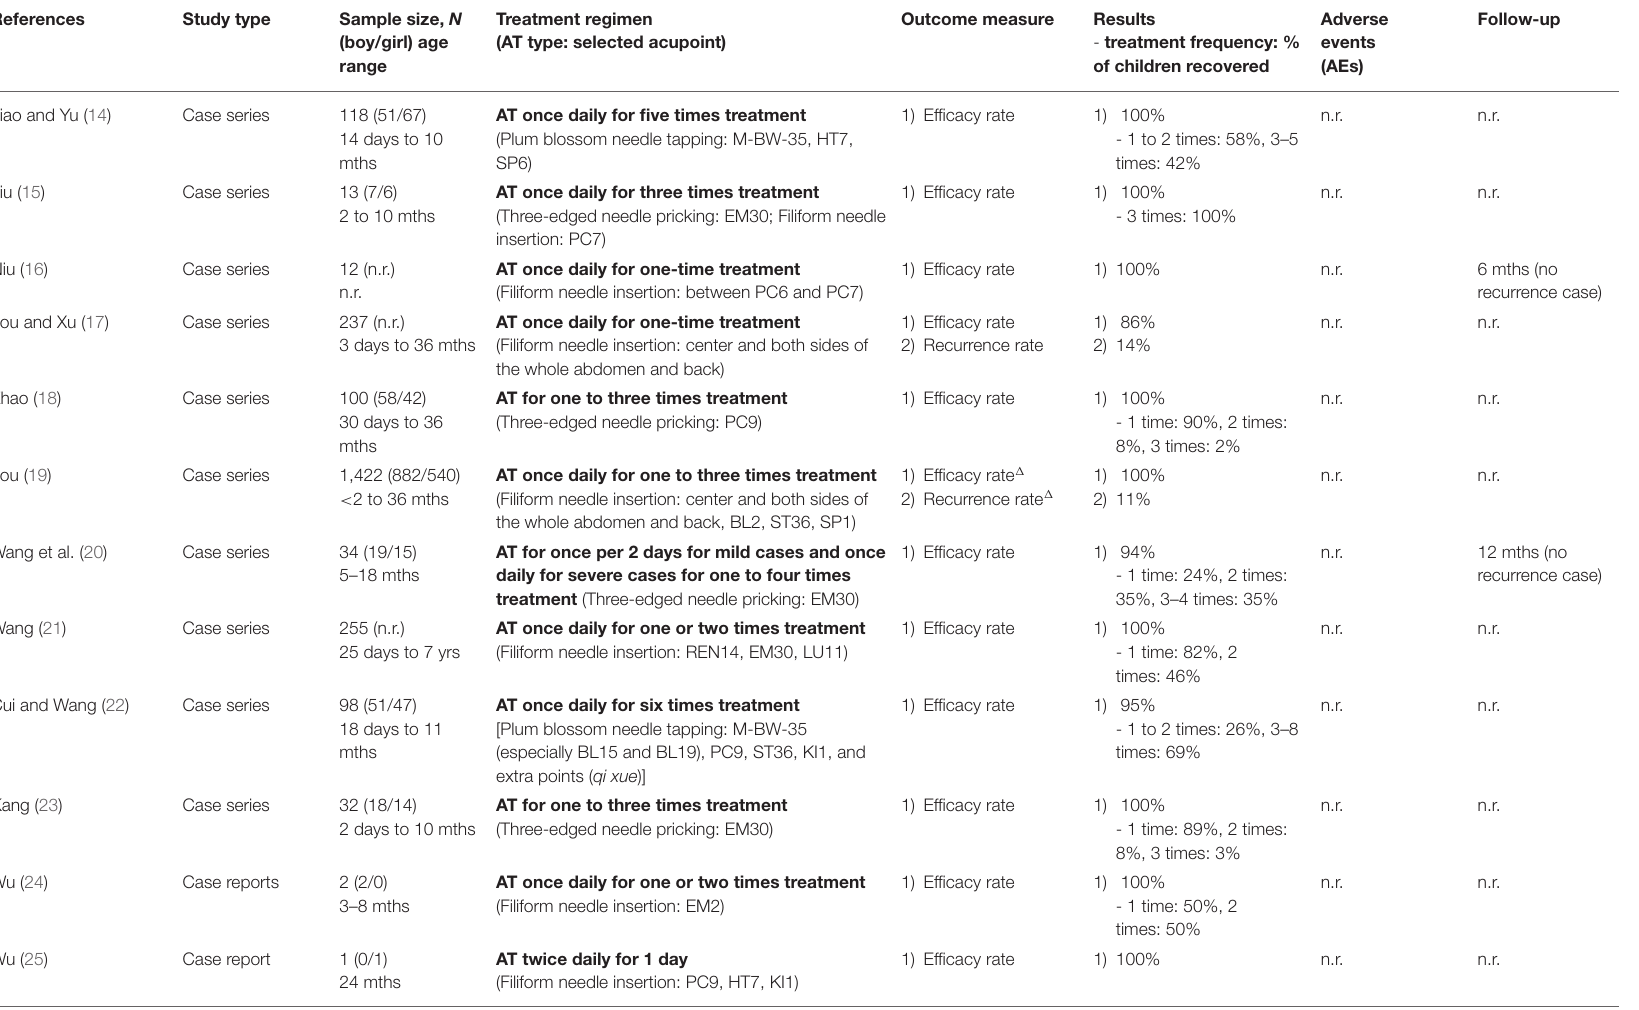
TABLE 1 | Summary of study